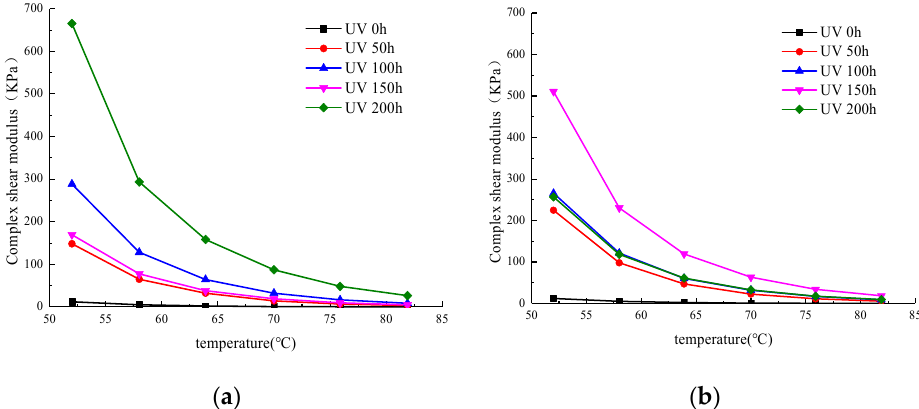
Figure 4. Complex shear modulus of WMA. ( a ) Oxygen isolation conditions. ( b ) Oxygen-containing conditions.